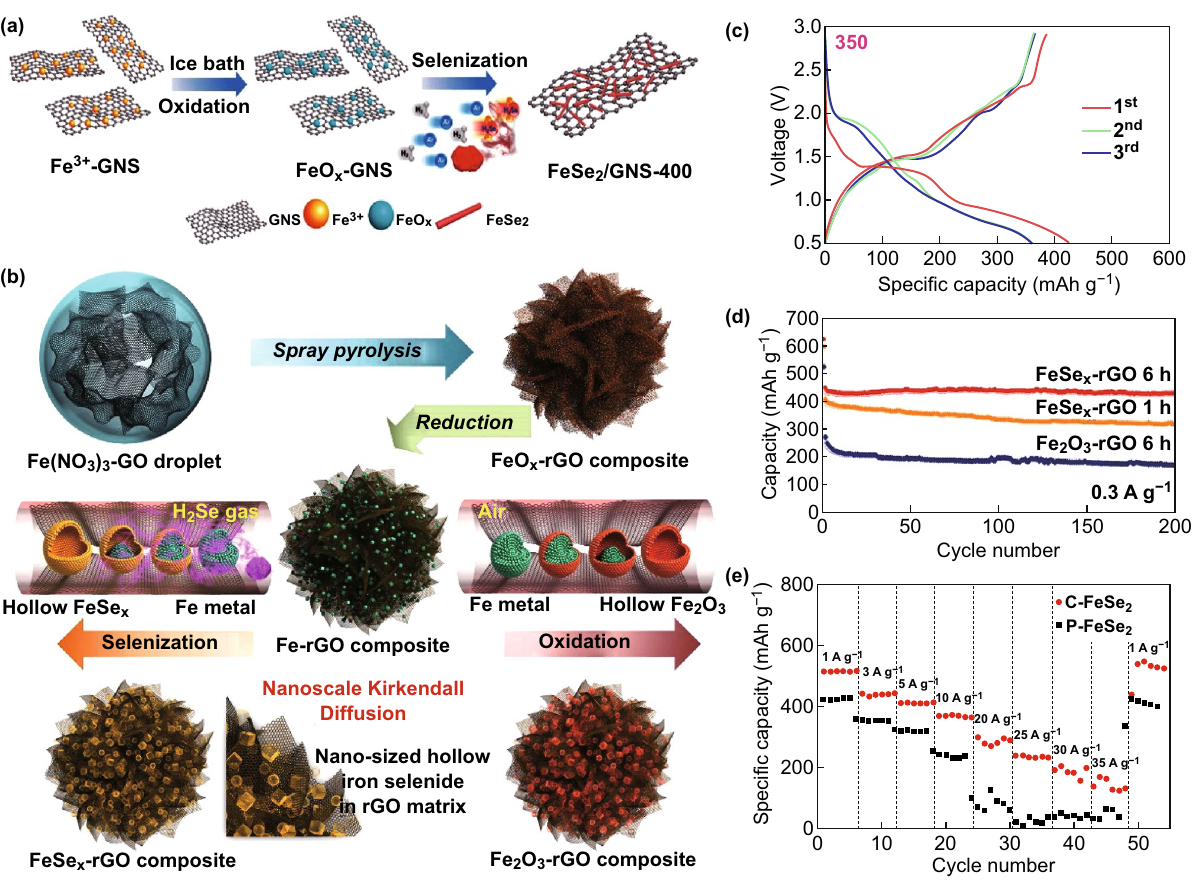
Fig. 8 a Schematic diagram of the synthesis of FeSe 2 /GNS-400. b Hollow FeSe x nanoparticles and hollow Fe 2 O 3 nanoparticles modify the for- mation mechanism of rGO composite powder by nano-Gildo diffusion. c Initial three charge and discharge curves of FeSe 2 /GNS-300 and FeSe 2 / GNS-400. d Electrochemical performance of the hollow FeSe x - and Fe 2 O 3 -decorated rGO composite powders: cycling performances. e Electro- chemical properties of the FeSe 2 electrode prepared for SIB. Rate performance of FeSe 2 clusters and particles after 50 cycles of current density from 1 to 35 A g −1 . Adapted from Refs. [58–60] with permission. Copyrights: 2018, American Chemical Society; 2016, Nature and 2017, Tsing- hua University Press and Springer-Verlag GmbH